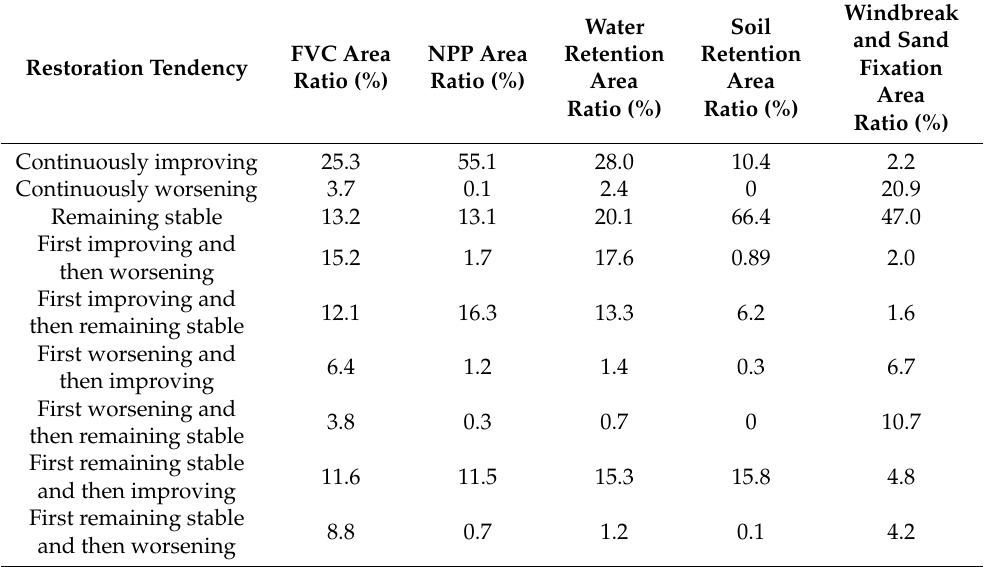
Table 5. Statistical table listing the restoration tendencies of the ecosystem quality and service factors considered